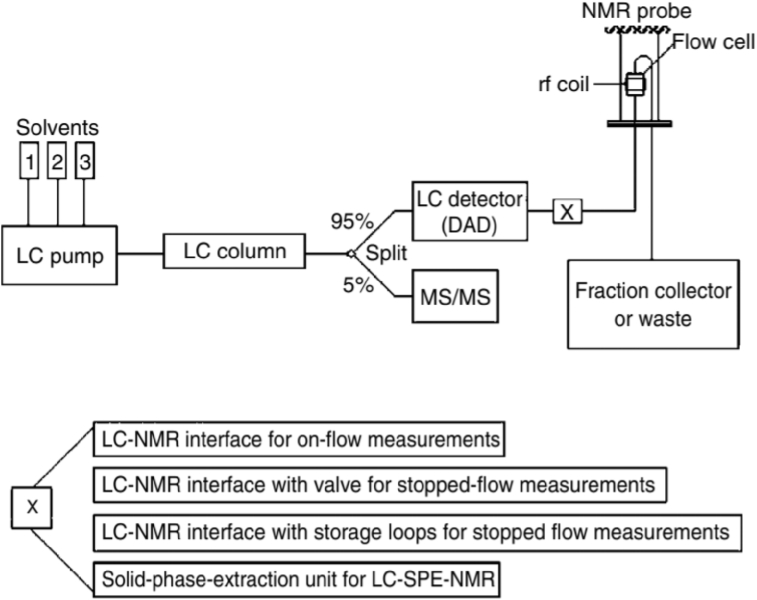
Operation mode of LC-NMR. Reproduced from Exarchou et al. (2005). Figure reproduced with permission from John Wiley & Sons.